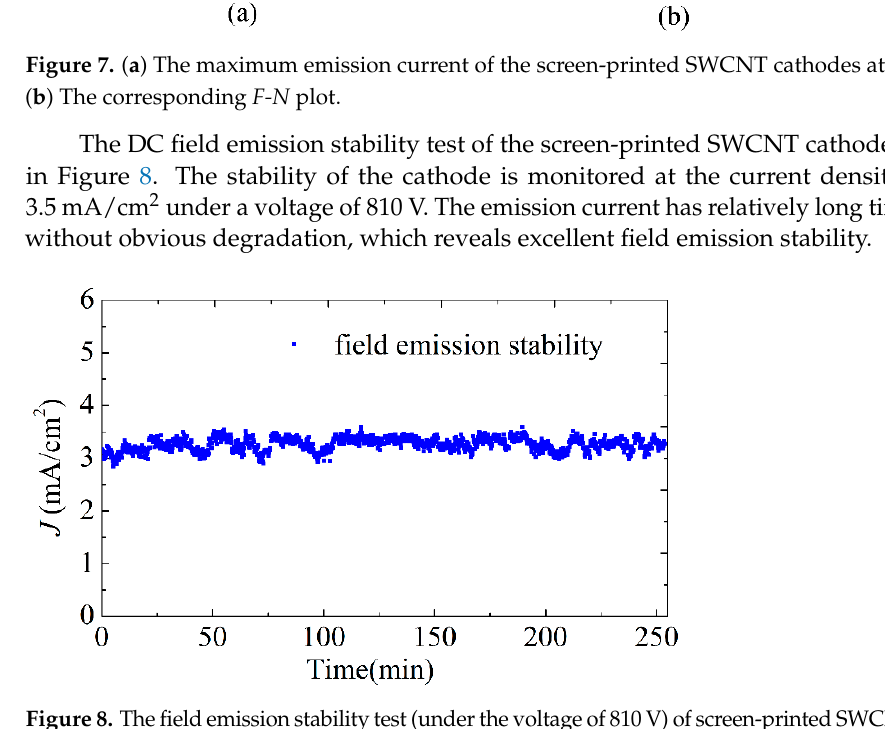
Figure 8. The field emission stability test (under the voltage of 810 V) of screen-printed SWCNT cathodes.